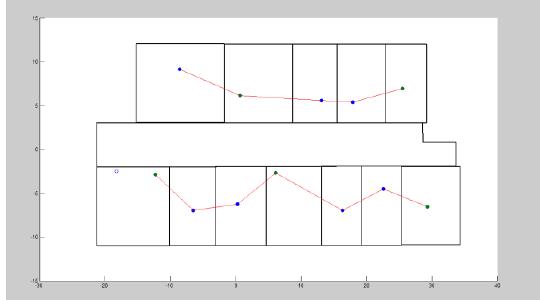
Figure 7. Test case 2 where surveying control points are represented as colored points, connection between dual nodes as red lines.